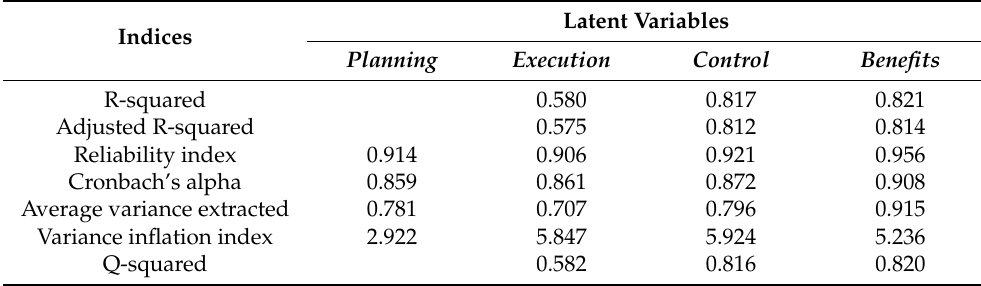
Table 3. Validation of latent variables.